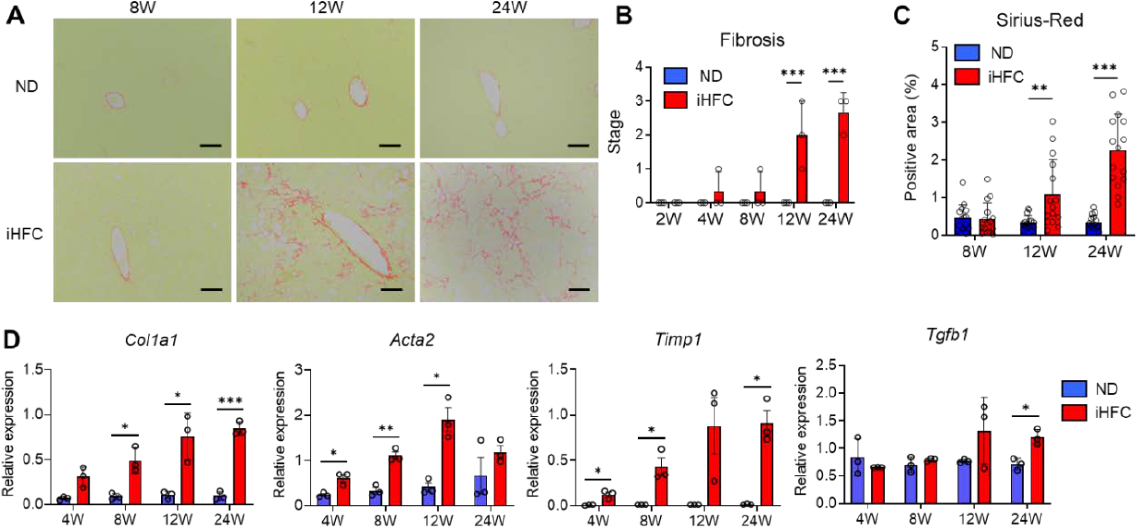
Figure 2. The iHFC diet induces advanced fibrosis in the liver of TSNO mice. ( A ) Representative images of Sirius red-stained sections of the livers from TSNO mice fed with the ND or iHFC diet for the indicated time periods. Scale bars, 100 µ m. ( B ) Liver fibrosis (0 to 4) was assessed according to the criteria proposed by Kleiner et al., as described in the Materials and Methods ( n = 3 per group). ( C ) Five locations were photographed per three sections per each group. Then, positive areas for Sirius red were measured at 15 locations using ImageJ software, and the mean and SD were calculated. ( D ) RT-qPCR of collagen type 1 ( Col1a1 ), α SMA ( Acta2 ), TIMP-1( Timp1 ), and TGF- β ( Tgfb1 ) mRNA in the livers from TSNO mice fed with the ND or iHFC diet for the indicated time periods ( n = 3 per group). Data are shown as means ± SD. * p < 0.05, ** p < 0.01, *** p < 0.001. Statisti- cal significance was evaluated by 2-way ANOVA followed by post hoc Sidak